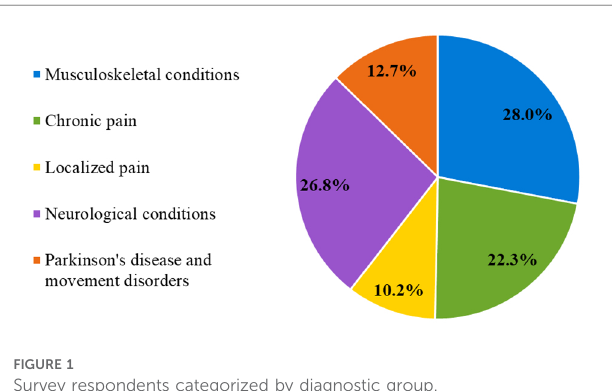
FIGURE 1 Survey respondents categorized by diagnostic group.